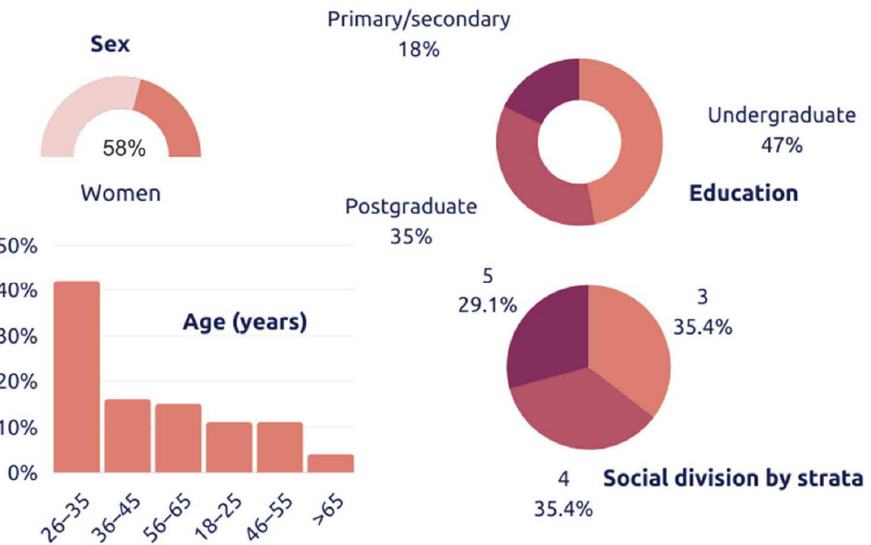
Figure 1. Descriptive statistics of consumers who resided in the Valle del Cauca, Colombia. ( n = 84).